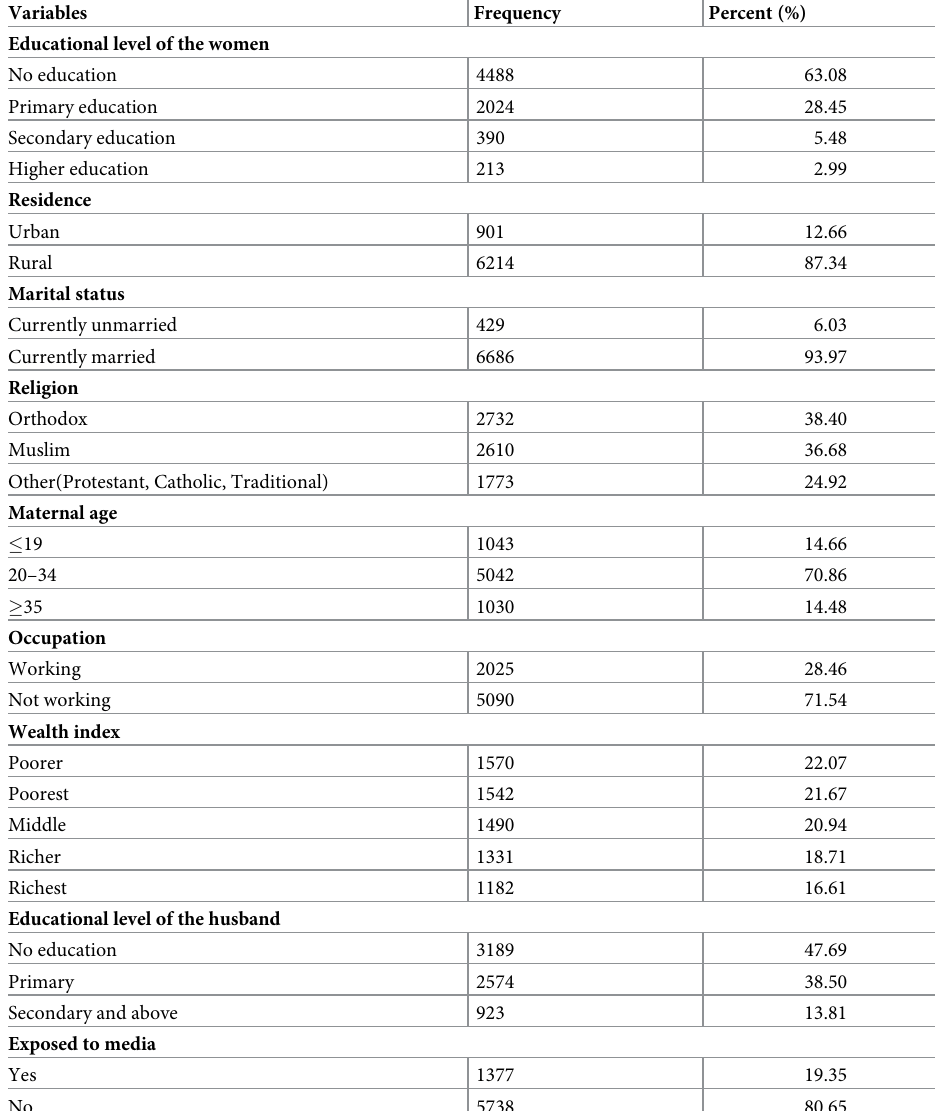
Table 1. Socio-demographic